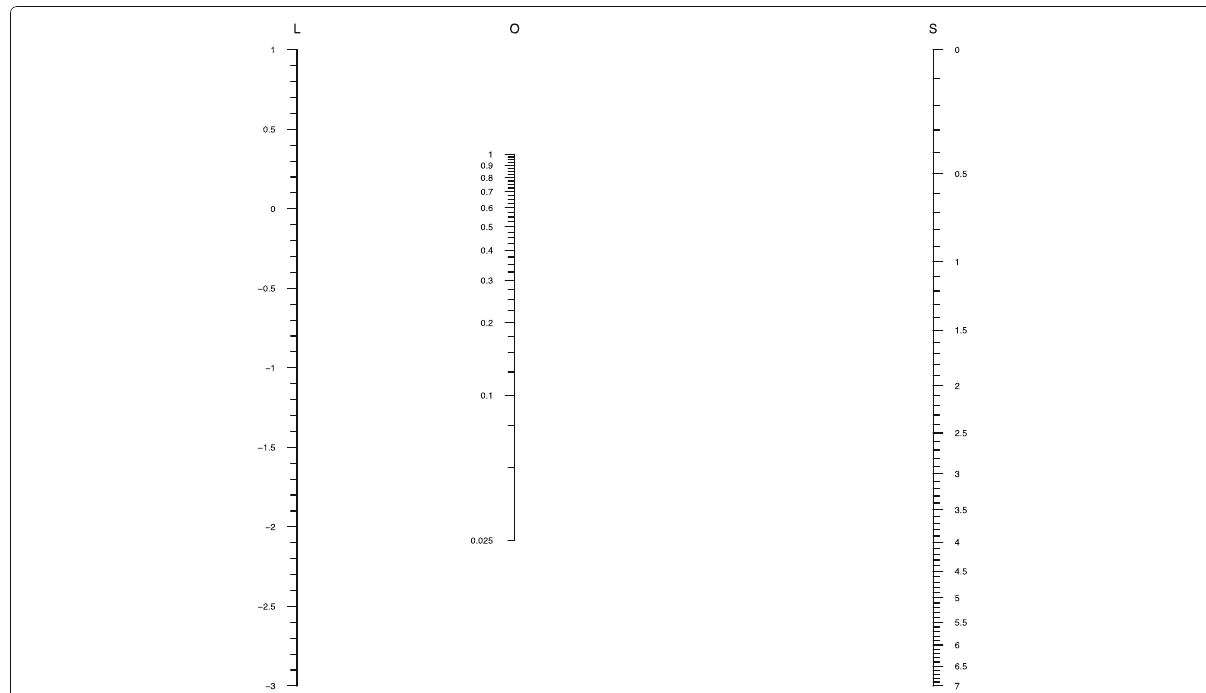
Fig.1 Generic nomogram for reporting multinomial logistic regression analysis. AxisL : lp k ( x i ) , AxisO : probability of outcome k , AxisS :